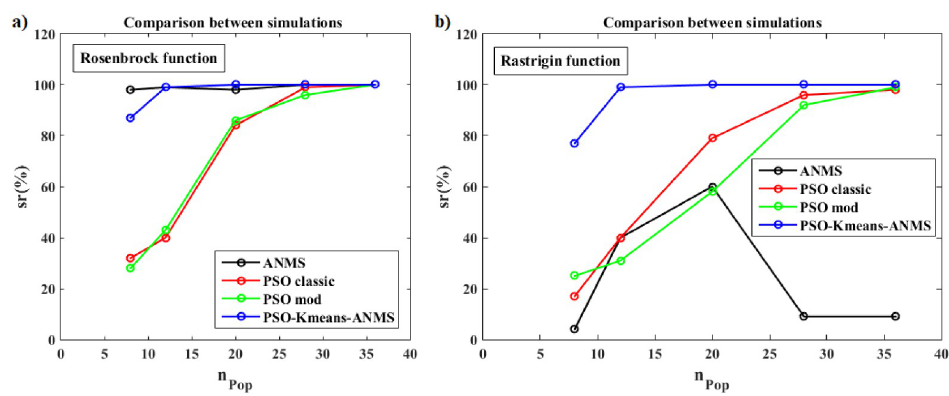
Fig 12. Comparison between simulations for all algorithms (success rate versus number of swarm particles). (a) Rosenbrock function and (b) Rastrigin function.